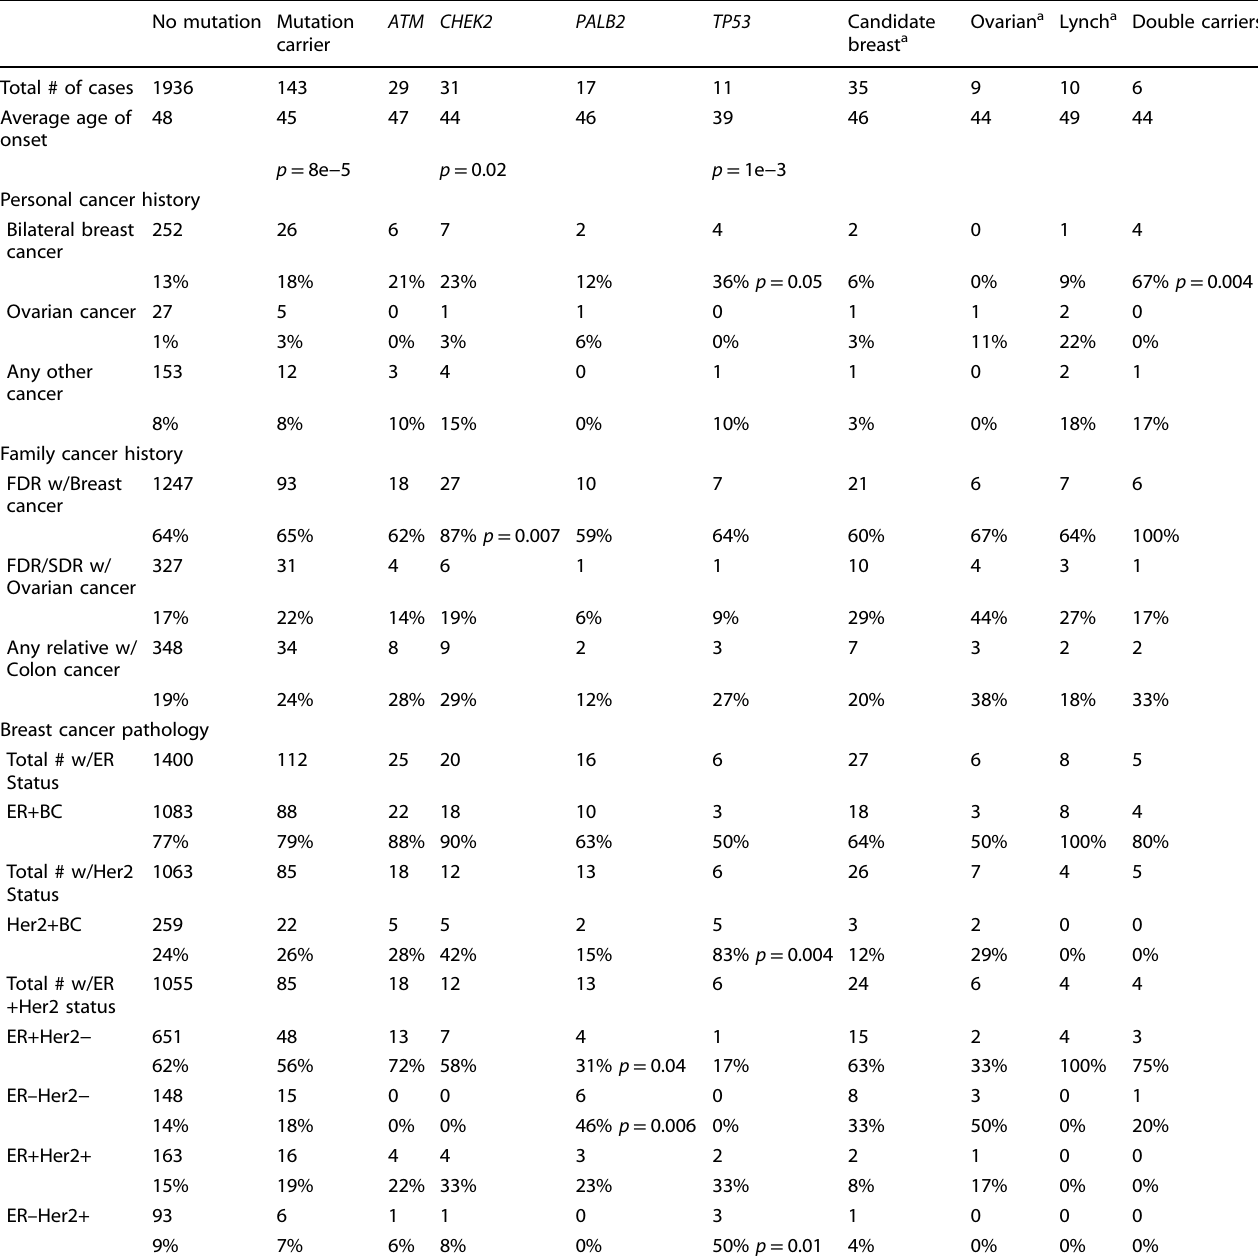
Table 4. Cancer history and breast cancer pathology characteristics of mutation carriers compared to non-mutation carriers